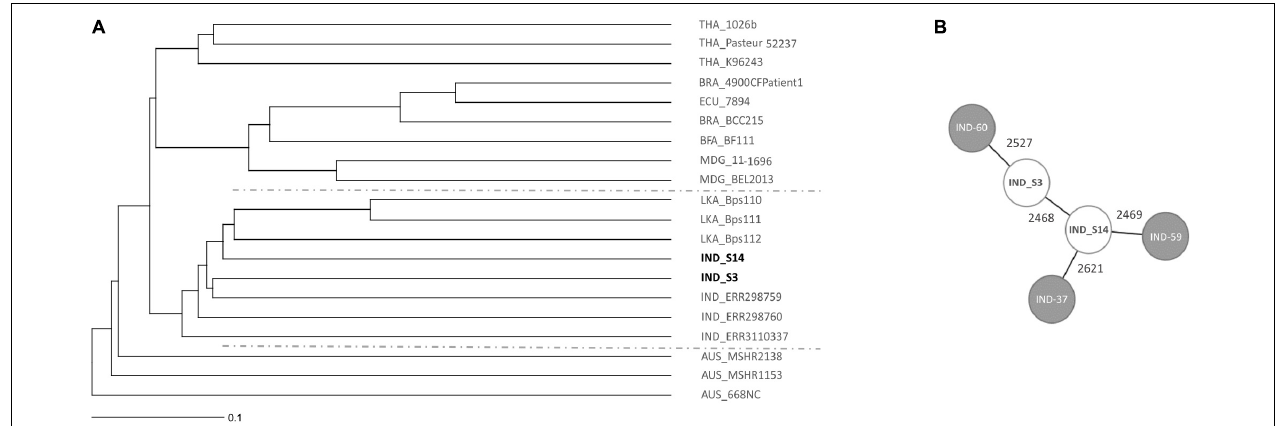
FIGURE 9 | Core genome MLST (cgMLST)-based genomic comparison of the isolated Indian B. pseudomallei strains with a diverse, global collection of B. pseudomallei strains. (A) The UPGMA tree shows clustering of soil isolates from this study with other B. pseudomallei isolates from different parts of the world. The line in the lower left corner illustrates 0.1% cGLMST column difference (% of core genome target differences). The geographic origin of strains is given as country code prior to the strain name (THA Thailand, BRA Brazil, ECU Ecuador, BFA Burkina Faso, MDG Madagascar, IND India, LKA Sri Lanka, AUS Australia). (B) A cgMLST-based minimum spanning tree illustrates the genetic diversity of Indian isolates. Isolate names are given as short forms: IND-60 refers to ERR298760, IND-59 to ERR298759 and IND-37 to RR3110337. The numbers on the connecting lines refer to the number of allele differences. Strains included with accession numbers of respective databases are listed in Supplementary Table 1